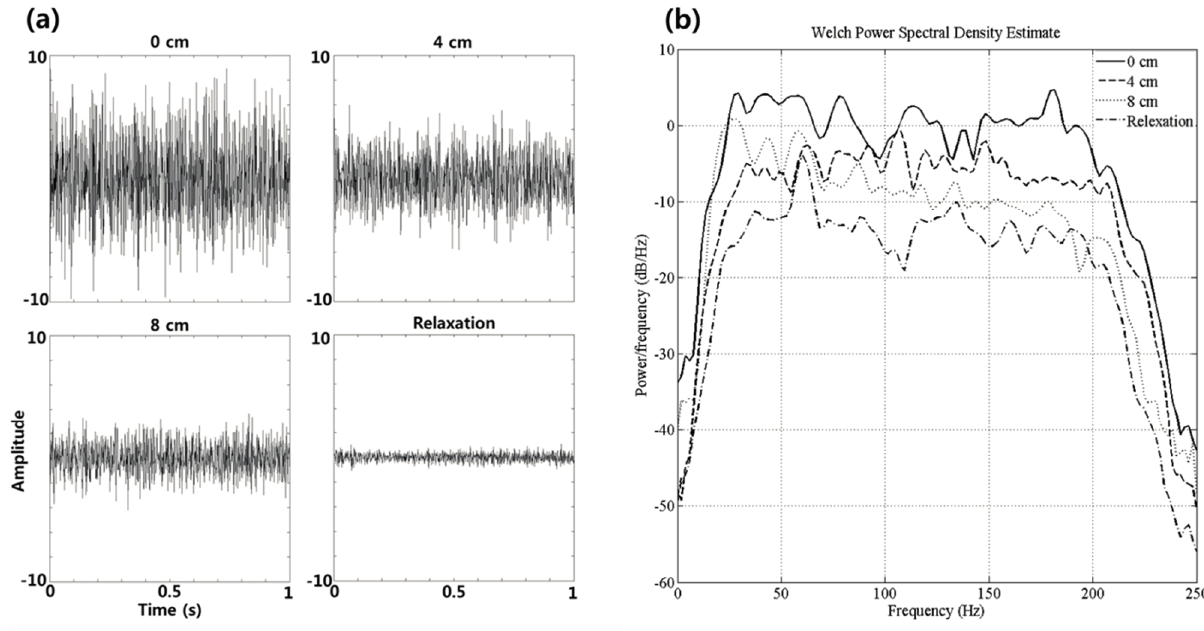
Figure 5. ( a ) sEMG time-series data. Amplitude of the EMG is more increased as the distance between thumb and index finger is shorter; ( b ) The power spectral density for